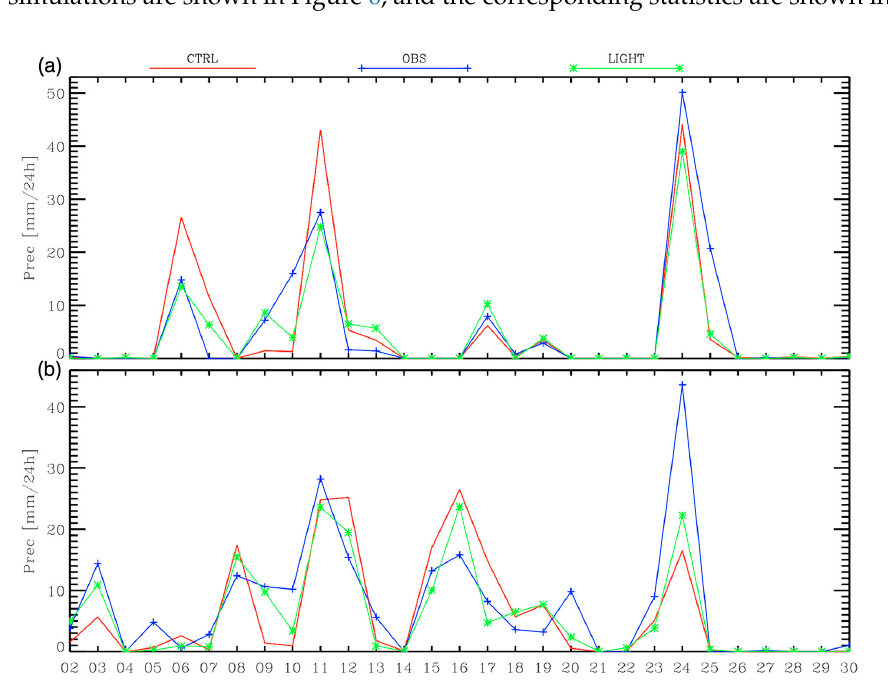
Figure 6. Time series of daily rainfall for Lipari ( a ) and Elba ( b ) islands. Observations are in blue, CTRL forecasts in red, and LIGHT forecasts in green.